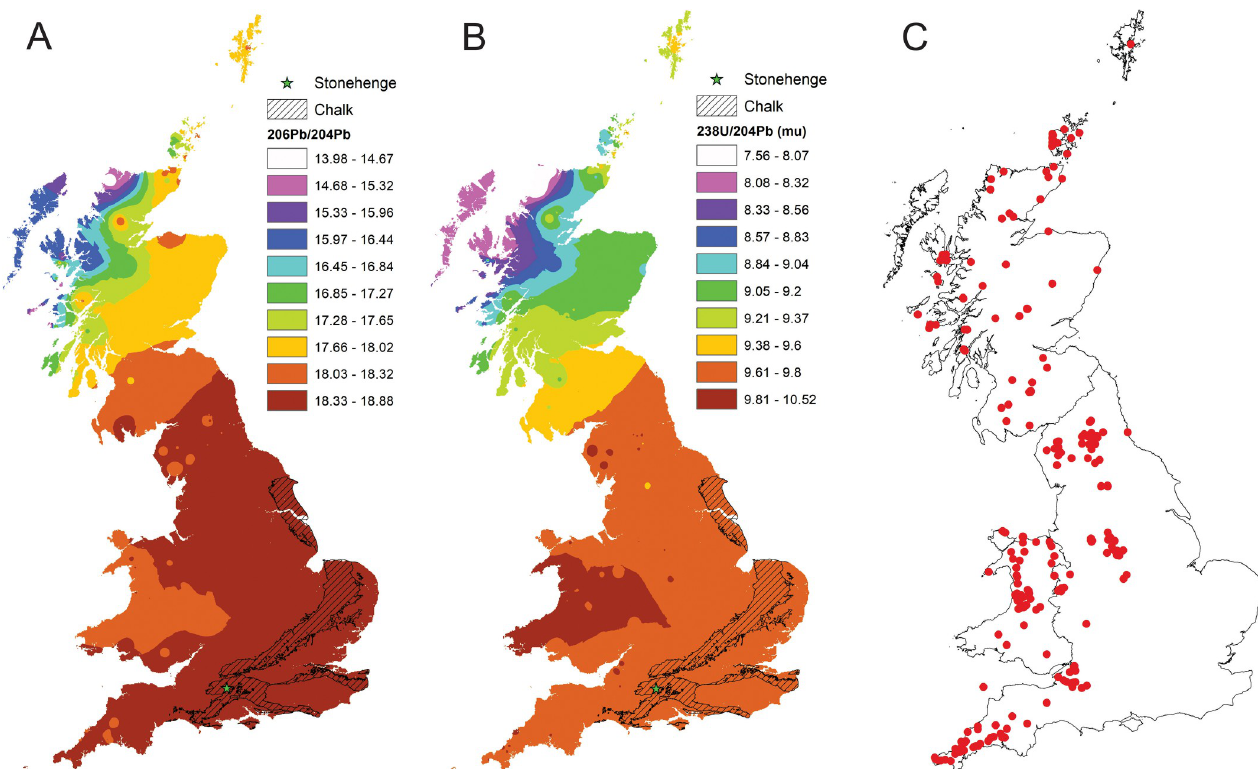
Fig 2. A contoured map of A) 206 Pb/ 204 Pb isotope compositions B) 238 U/ 204 Pb ( μ ) values from Great Britain C) samples locations. Data for this plot are taken from the compilation of [14–16, 19, 41] and this study. Contouring is based on Inverse Distance Weighting (IDW) with ten natural break intervals. Superimposed over this contour map is the outcrop area of Chalk. This has been designated data ranges of 206 Pb/ 204 Pb 18.81 ± 0.2(1SD, n = 26) and 238 U/ 204 Pb ( μ ) = 9.71 ± 0.24(1SD, n = 26). Contains OS data © Crown copyright and database rights